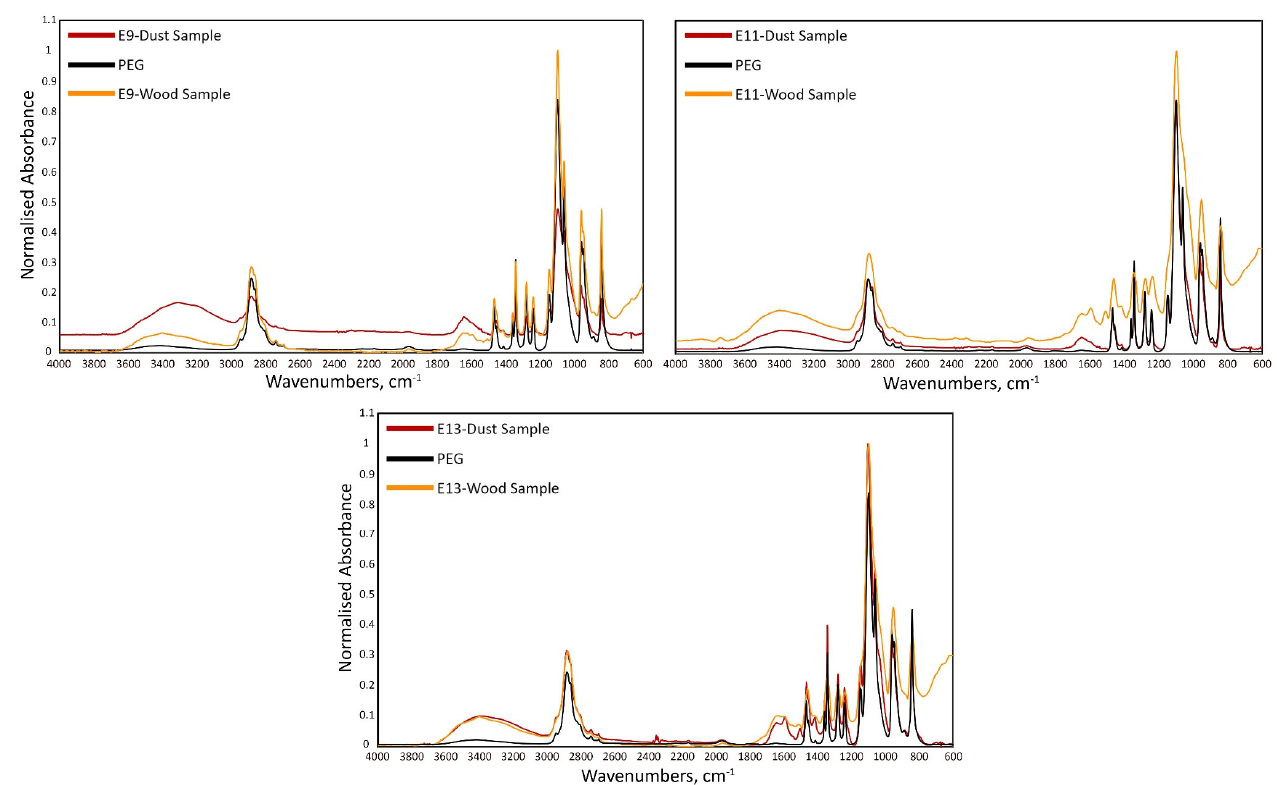
Figure 4. FTIR spectra collected for the E9, E11, and E13 dust samples, PEG, and archaeological wood samples